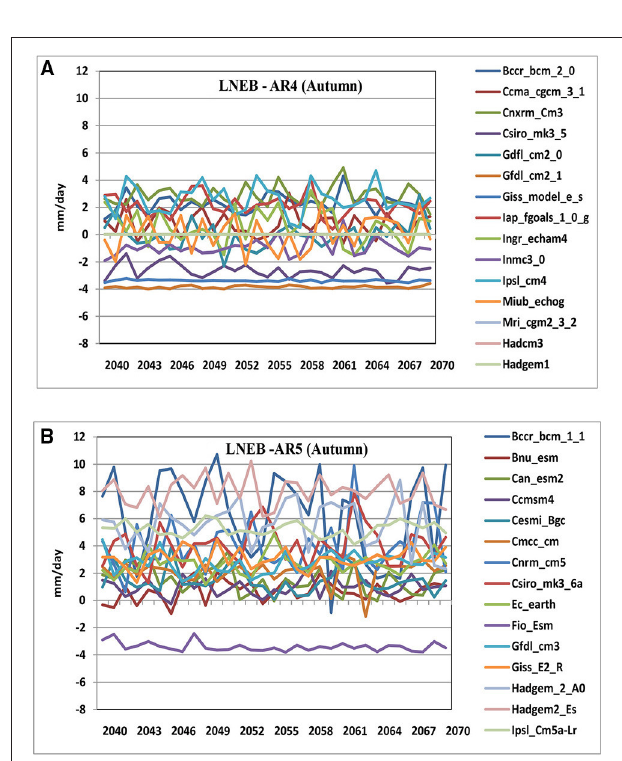
FIGURE 12 | As Figure 11 except for